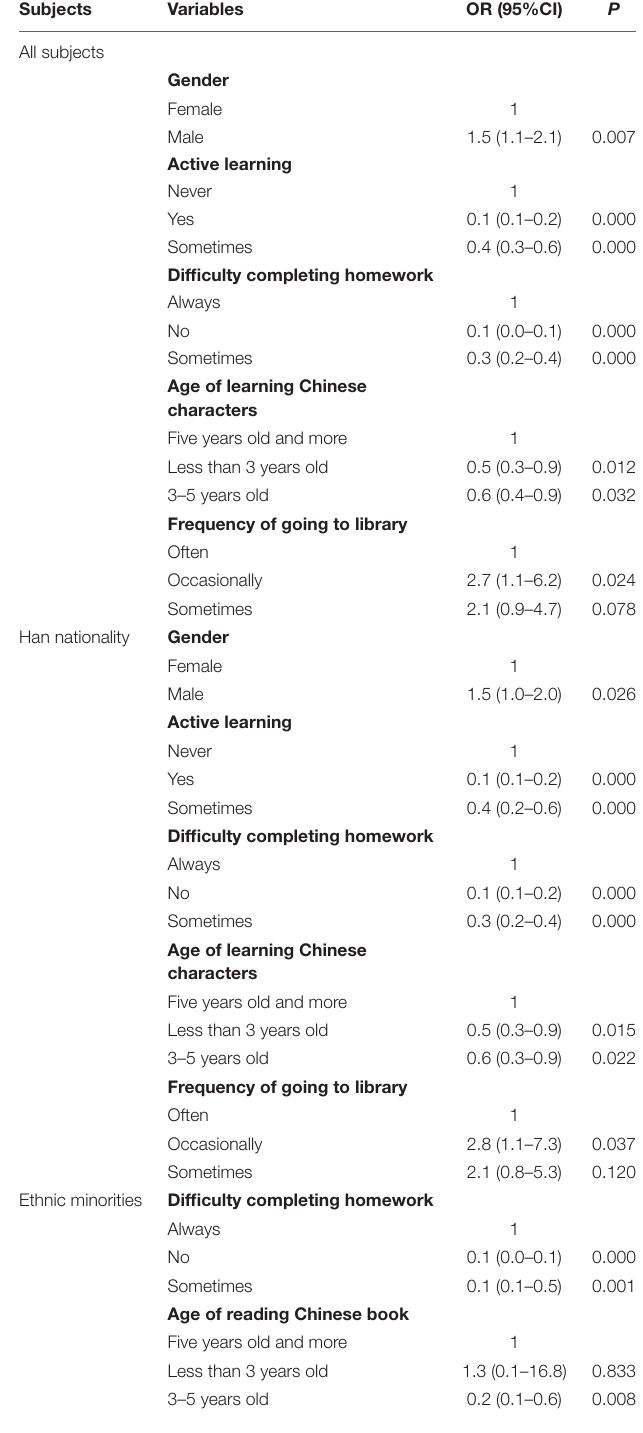
TABLE 4 | Multivariate logistic regression analysis of associated factors for